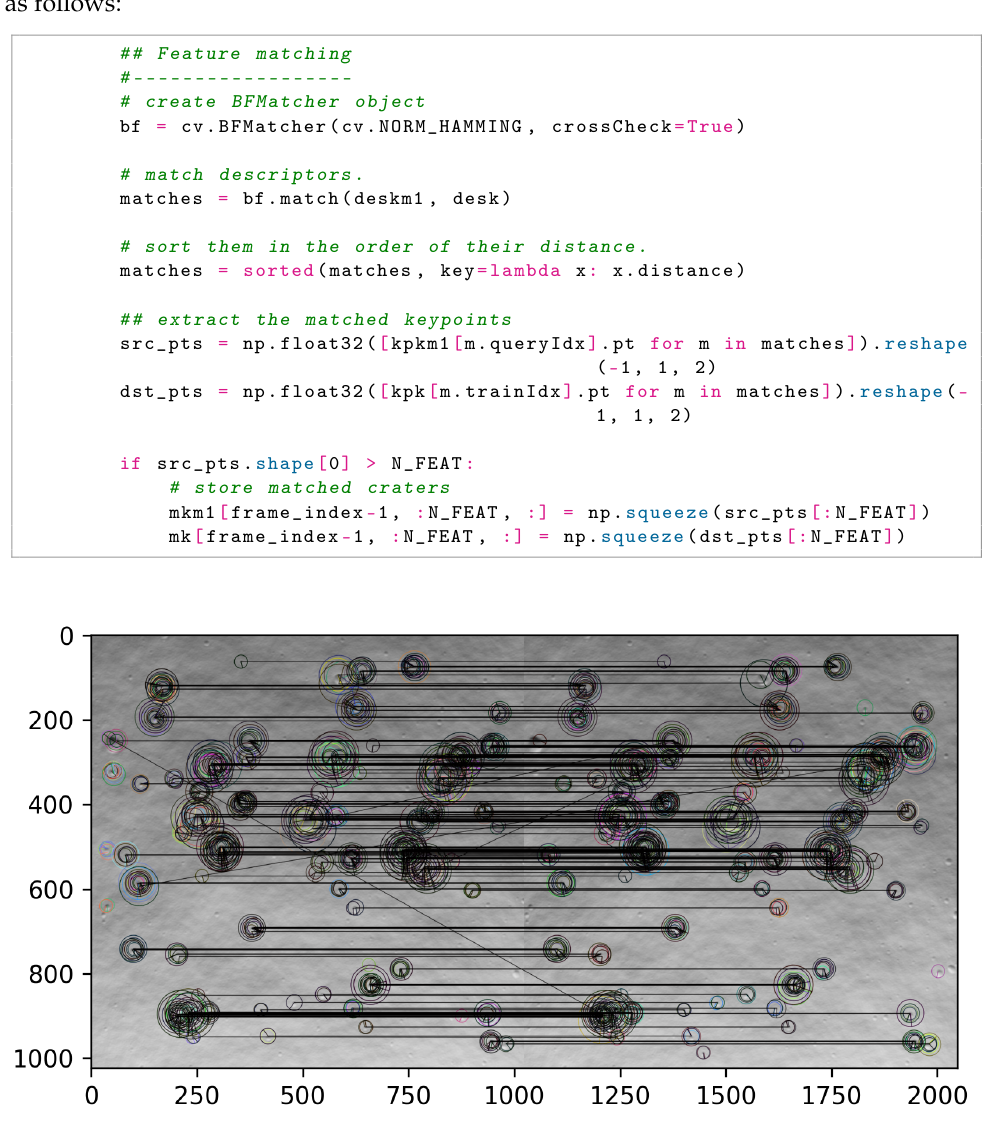
Figure 10. Frame-to-frame features detection and matching using ORB